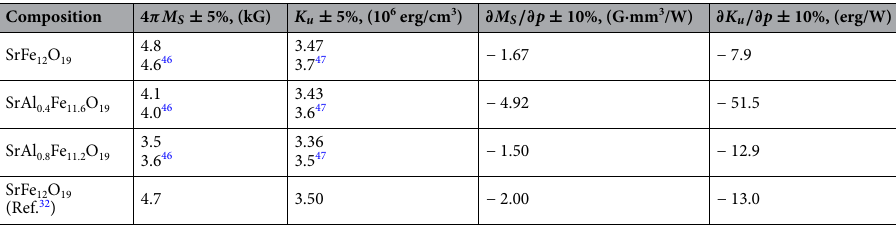
Table 1. Magnetic parameters and their dependence on applied DC power estimated from data on mode frequencies for aluminum-substituted M-type hexaferrites.